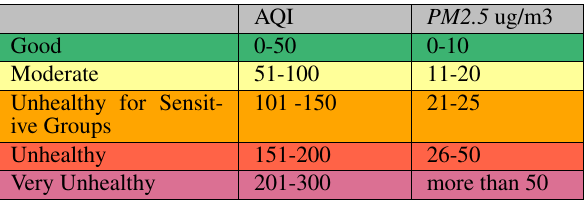
Table 1. AQI and PM2.5 Mapping (Fraser et al., 2016)